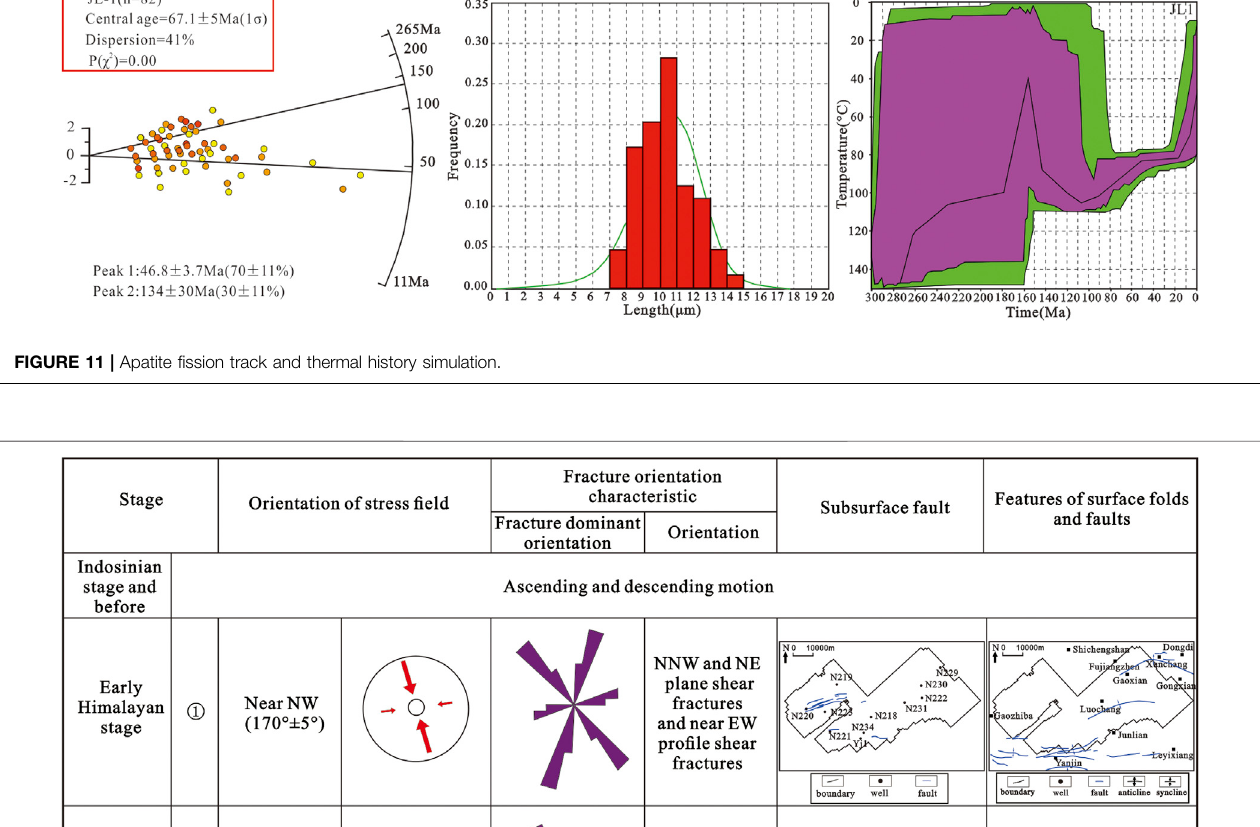
Frontiers in Earth Science |